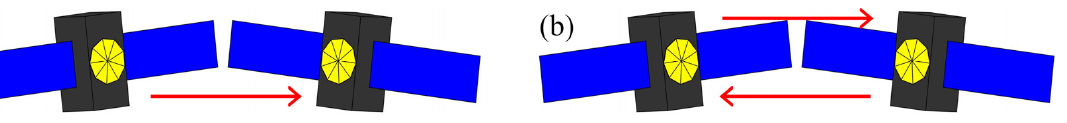
Figure 1. Connection type: ( a ) one-way and ( b ) dual one-way